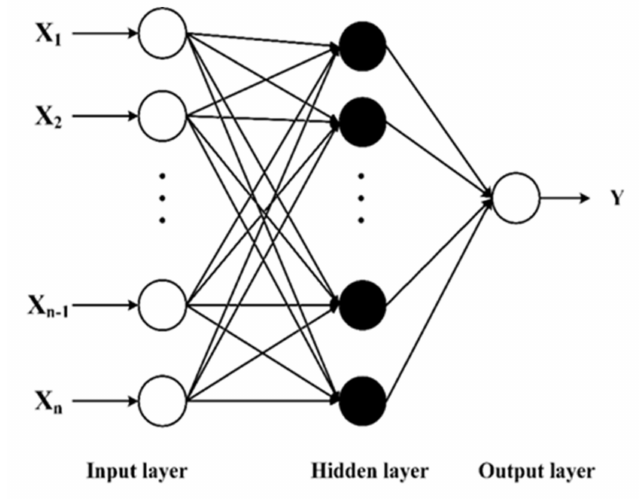
Figure 2. The basic structure of applied neural